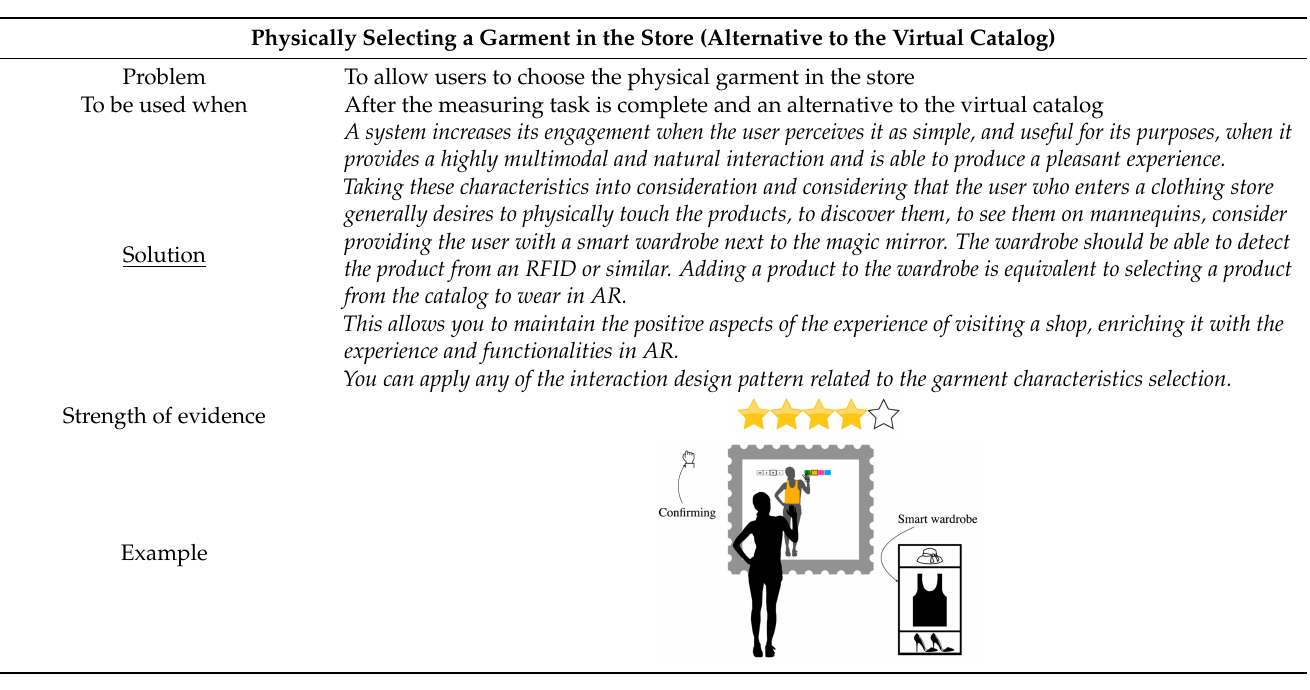
Table 9. Physically selecting a garment in the store.